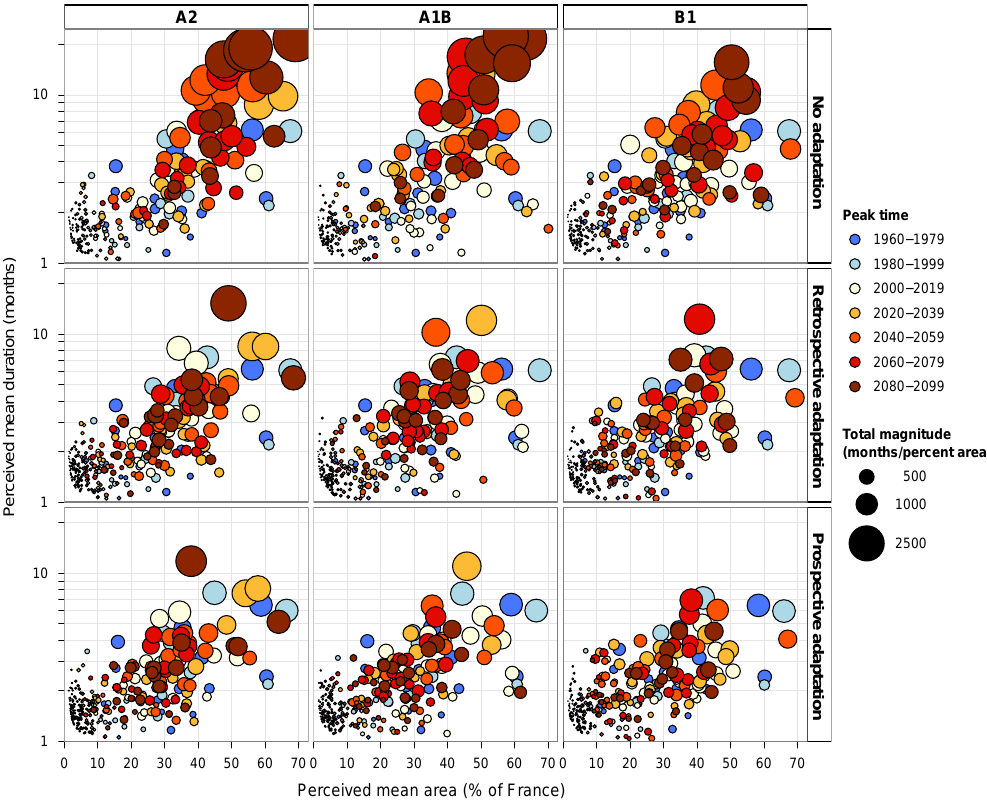
Fig. 7. Evolution of perceived spatio-temporal characteristics (mean area, mean duration and total magnitude) of short meteorological droughts, as defined by SPI3. Three emissions scenarios are considered along the columns, and three adaptation scenarios are considered along the